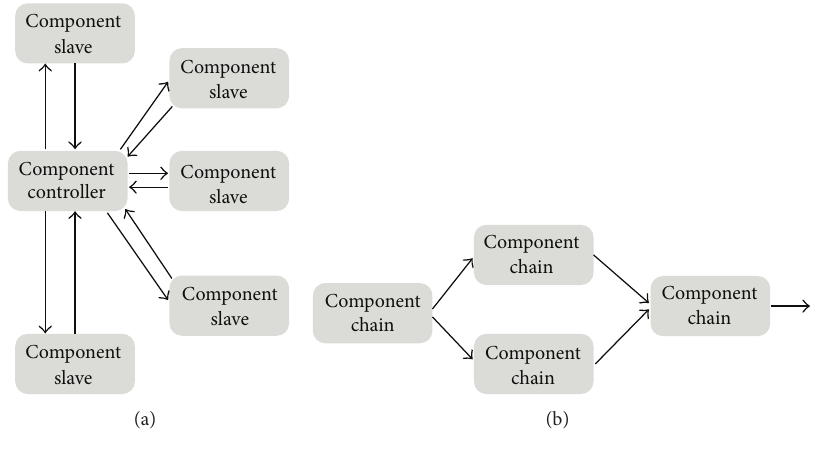
Figure 3: Applications